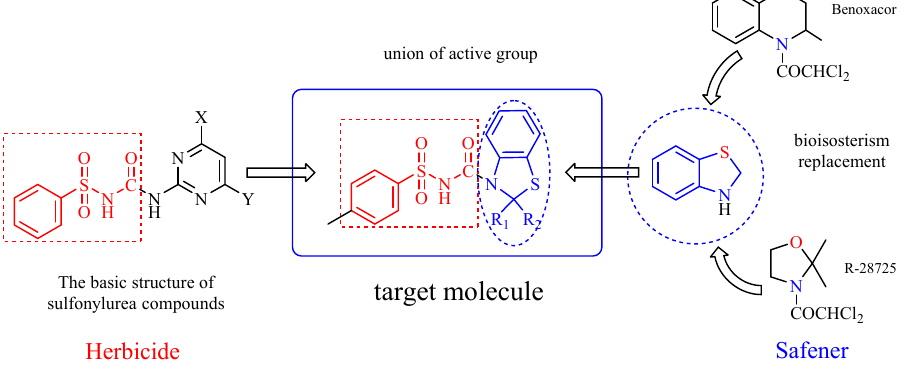
Scheme 2. The design of the target compounds.